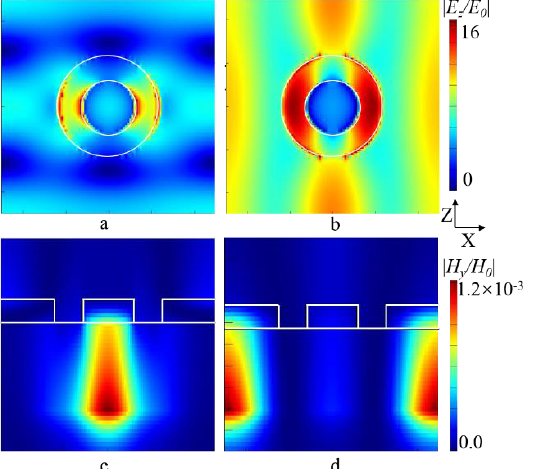
Figure 3. ( a ) Electric field diagram at λ 1 = 539 nm; ( b ) electric field diagram at λ 2 = 673 nm in XY plane; ( c ) magnetic field diagram at λ 1 = 539 nm; and ( d ) magnetic field diagram at λ 2 = 673 nm in XZ plane.